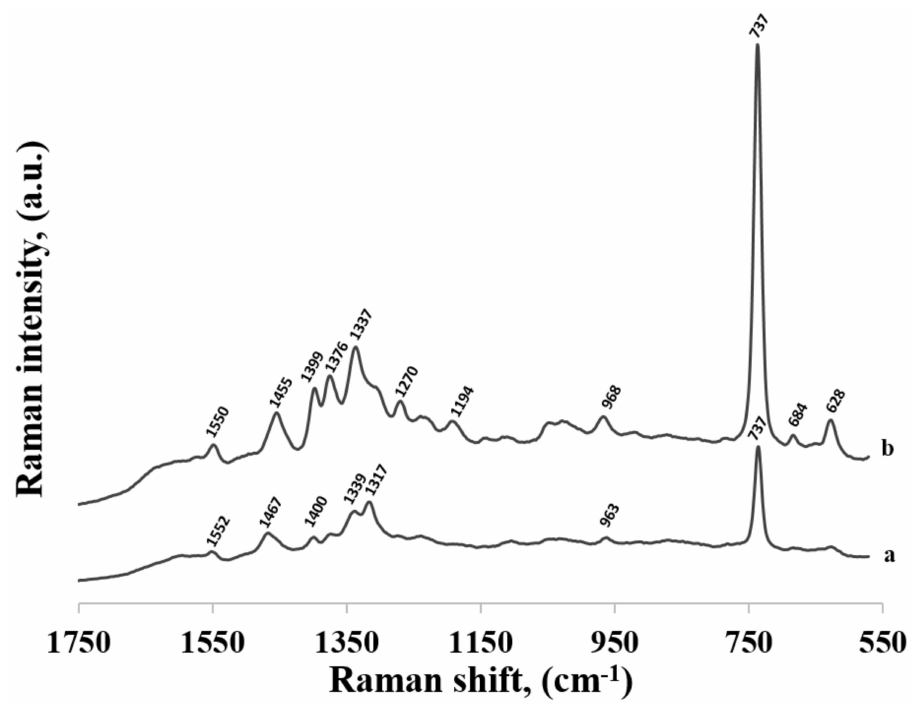
Figure 4. SERS spectra of: (a) thiolated adenine mononucleotide and (b) adenine adsorbed on gold